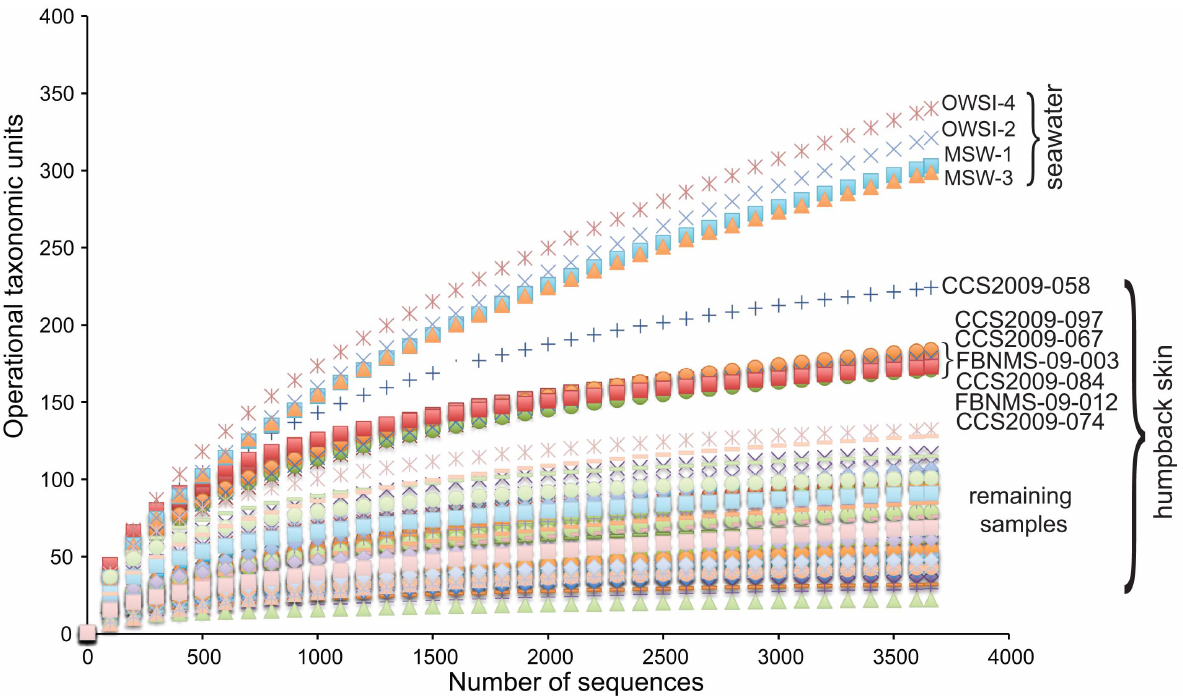
Figure 1. Rarefaction analysis of bacterial SSU rRNA gene sequences. This analysis represents data subsampled at 3,662 sequences per sample. Samples with OTU richness greater than 130 are listed by name.